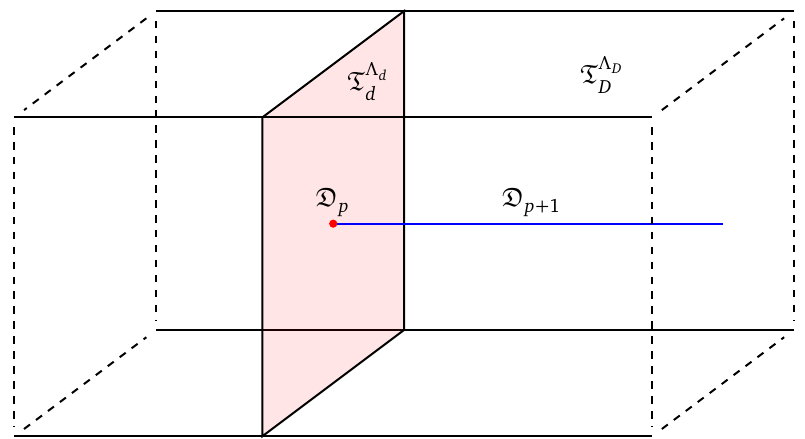
Λ d arising at the d Λ D . Such a D